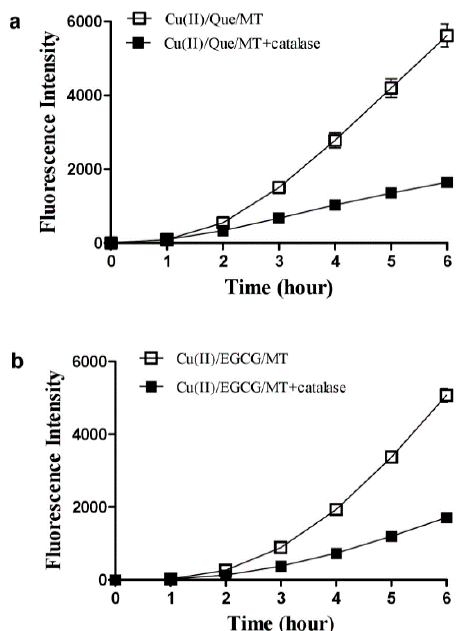
Figure 4. Hydrogen peroxide levels produced by dietary polyphenols. ( a ) quercetin (Que). ( b ) EGCG. ( c ) Comparison of different polyphenols (Lut: luteolin; CGA: chlorogenic acid). Chemicals were mixed in 0.02 M PBS (pH 8.0) and incubated at 37 ◦ C for indicated time in a and b or 1 h in c. Data are presented as the mean of two replicates; the error bar represents the range. In most data points, the range was smaller than the symbol.